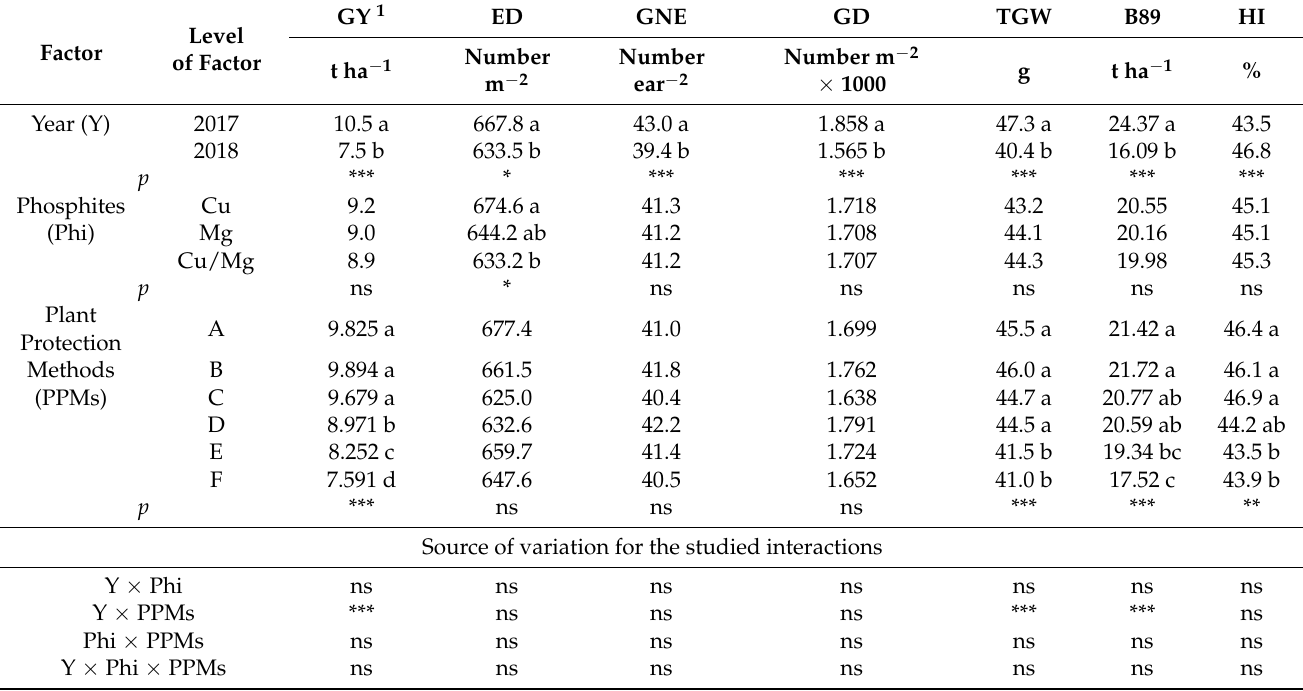
Table 3. Grain yield, yield components response to the method of winter wheat canopy foliar protection against